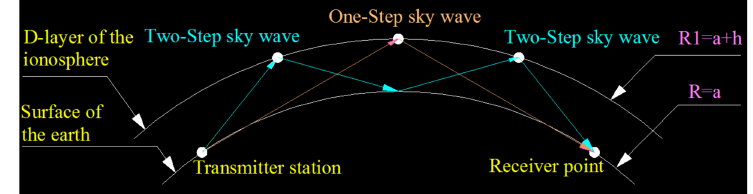
Figure 1. Sky wave propagation path of the low-frequency time-code